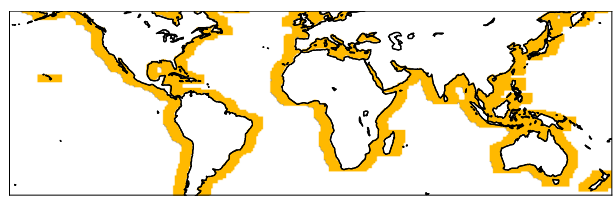
Figure C2. Convolution flag indicating regions where V (cid:48) is likely biased due to edge effects of convolution.